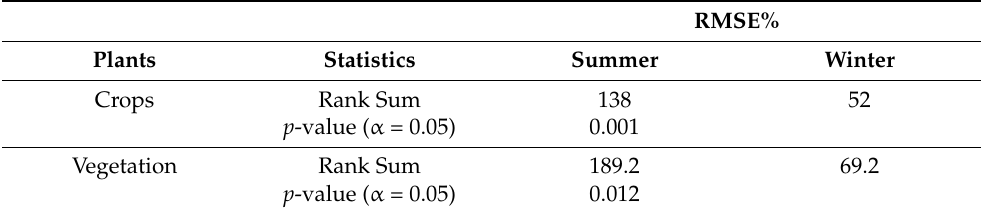
Table 6. Comparisons of nutrient estimation accuracies (RMSE %) between the summer and winter seasons in crops and vegetation,